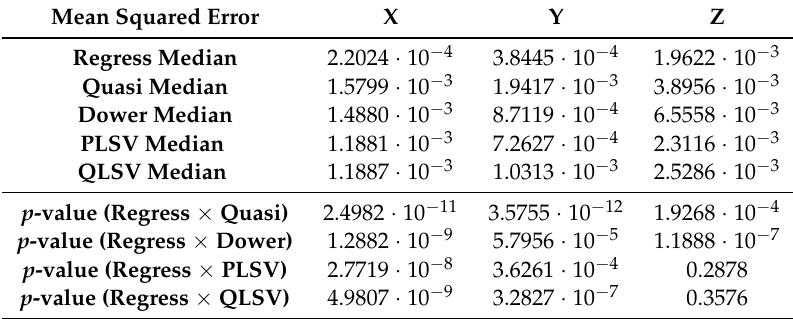
Table 5. Table of the medians of the MSE results for individual transformation methods and individual leads and the resulting p -values between the medians of Kors regression transformation and the medians of other transformation methods for individual